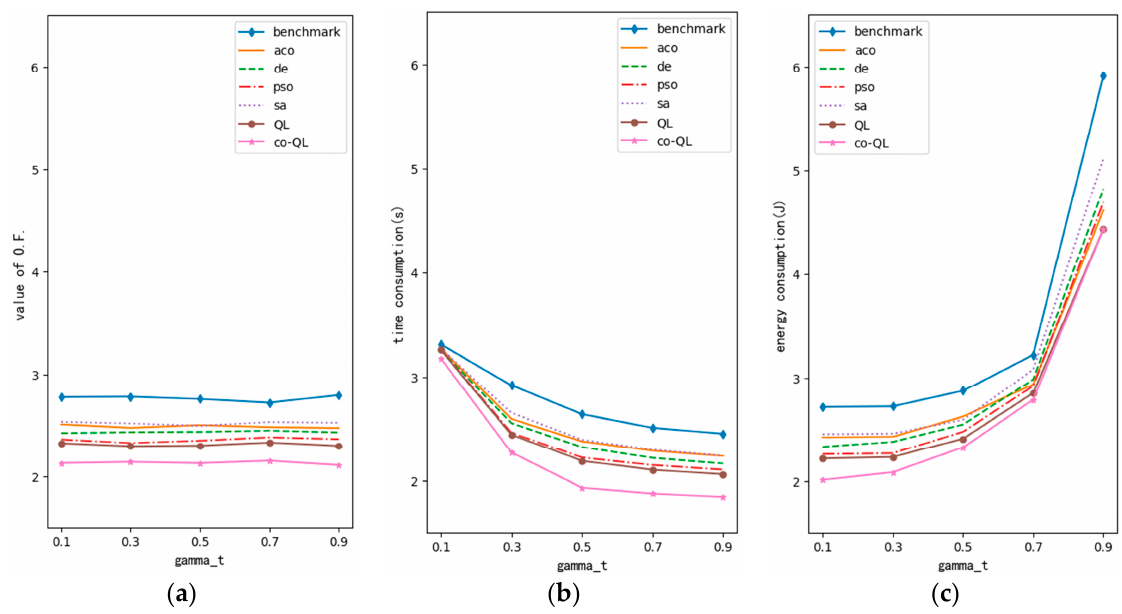
Figure 11. Optimization performance curve of variable γ t (M = 3, N = 4, G = 1): ( a ) curve for value of objective function; ( b ) curve for time consumption; ( c ) curve for energy consumption.